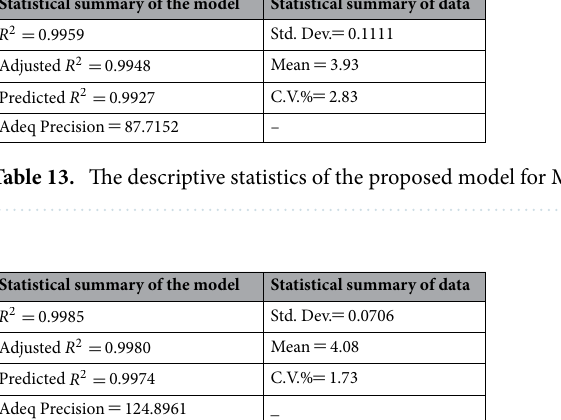
Table 14. The descriptive statistics of the proposed model for Merkel number using TiO 2 nanofluid.